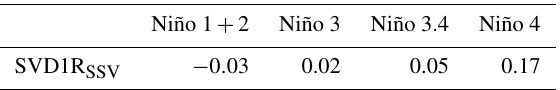
Table 2. Pairwise correlation coefficients between SVD1R SSV and the Niño indices (described in Sect. 2.3). None of the correlations are